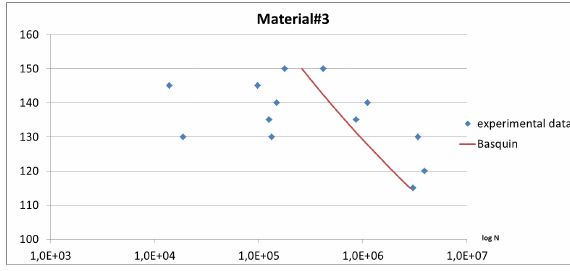
Figure 6. Optimal fatigue model for